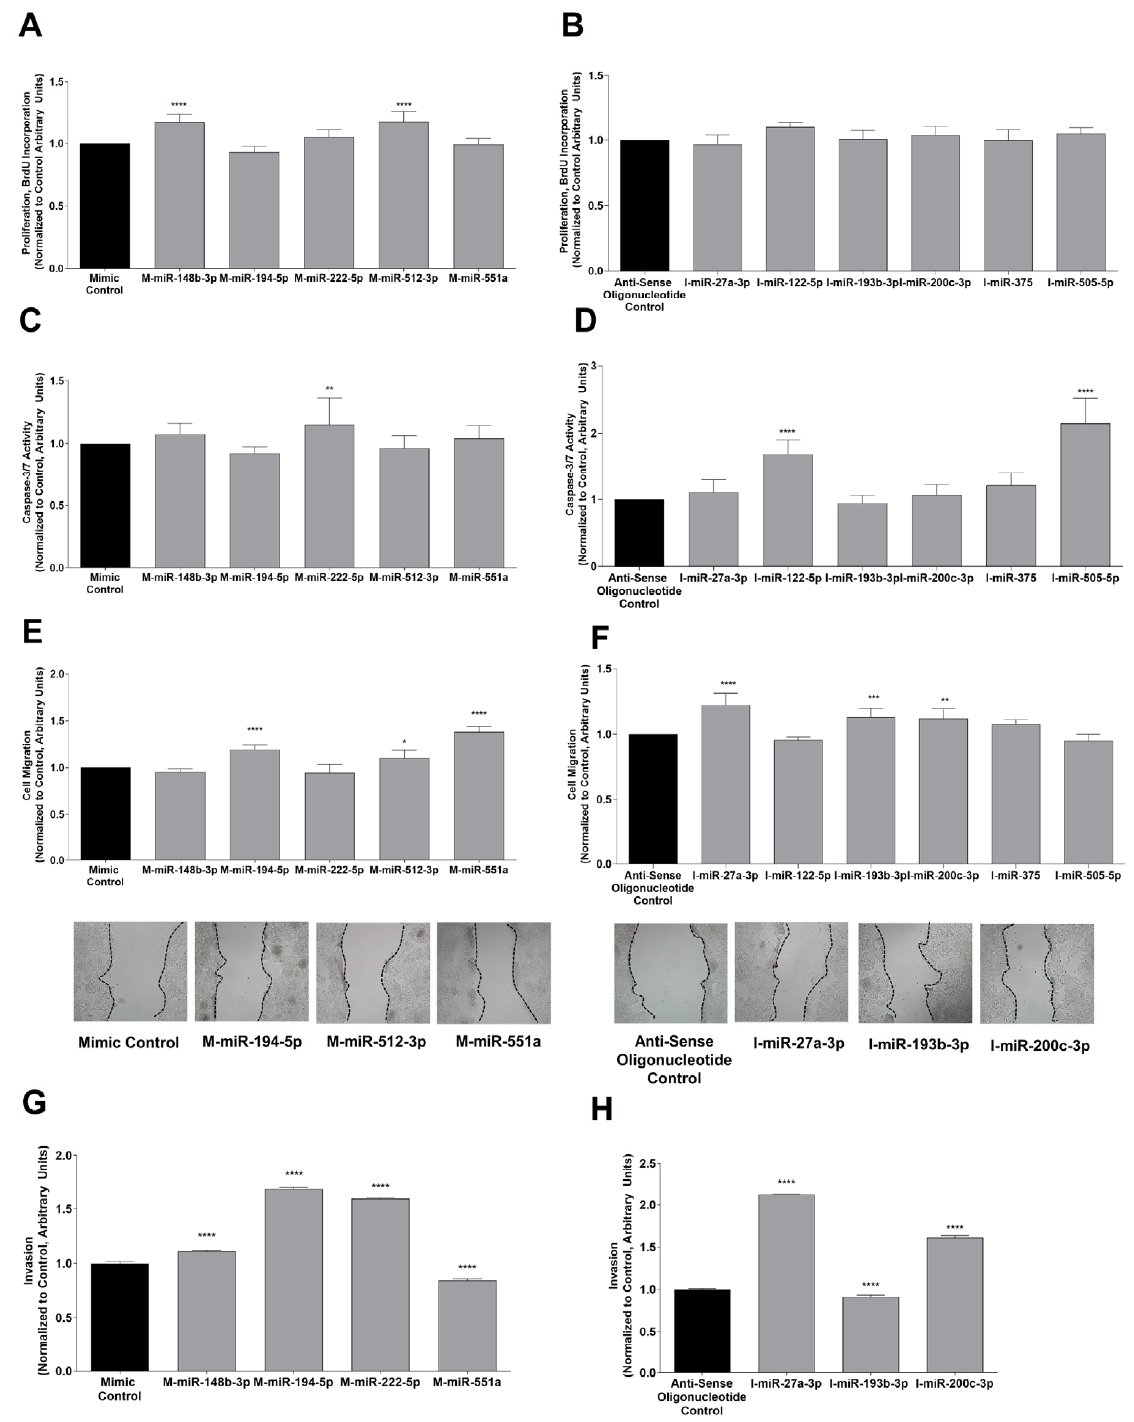
Figure 3. Functional analysis with mimics (left panel) and inhibitors (right panel) of differentially expressed miRNAs in HepG2 cells treated with Sorafenib. Proliferation (mimics A , inhibitors B ), caspase-3/7 activity (mimics C , inhibitors D ), migration (mimics E , inhibitors F ), and invasion (mimics G , inhibitors H ) were tested to unravel anti- or pro-tumoral effects of miRNAs after Sorafenib treatment. Invasion was tested for the miRNA mimics and inhibitors that showed the upregulation of cell migration with p -value < 0.01, or those that downregulated cell migration more that 5%. * p ≤ 0.05, ** p ≤ 0.01, *** p ≤ 0.001, and **** p ≤ 0.0001 between the transfection control and mimic or inhibitor tested.